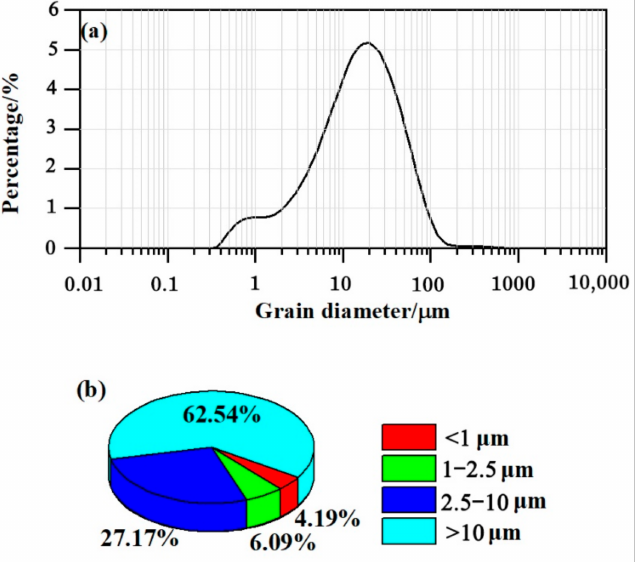
Figure 2. ( a ) The particle size frequency distribution curve of particles deposited on needles. ( b ) The percentages of the particle size fractions (0.02–1 µ m, 1–2.5 µ m, 2.5–10 µ m, and >10 µ